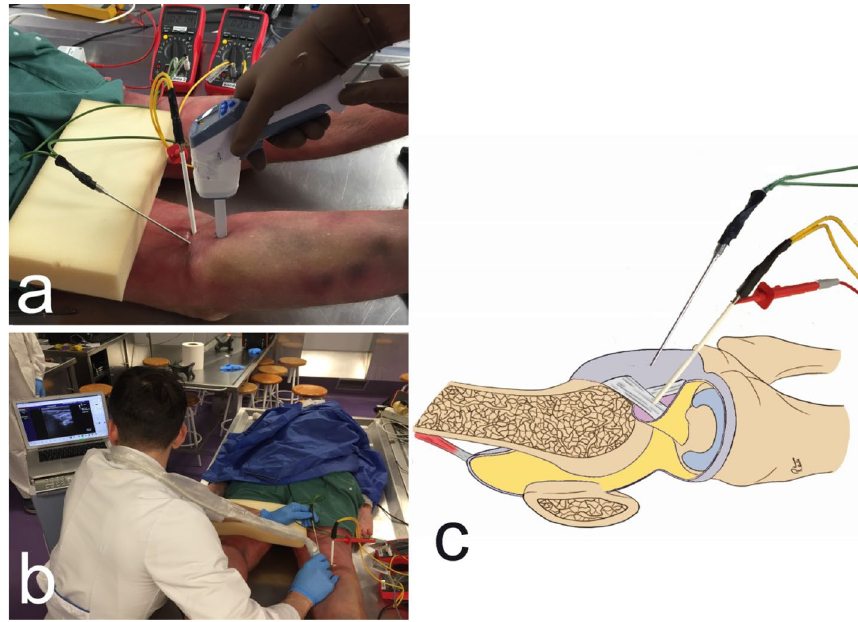
Figure 5. ( a ) Temperature measurement with digital thermometer, ( b ) Thermocouple placement under ultrasound guidance, ( c ) Thermocouple